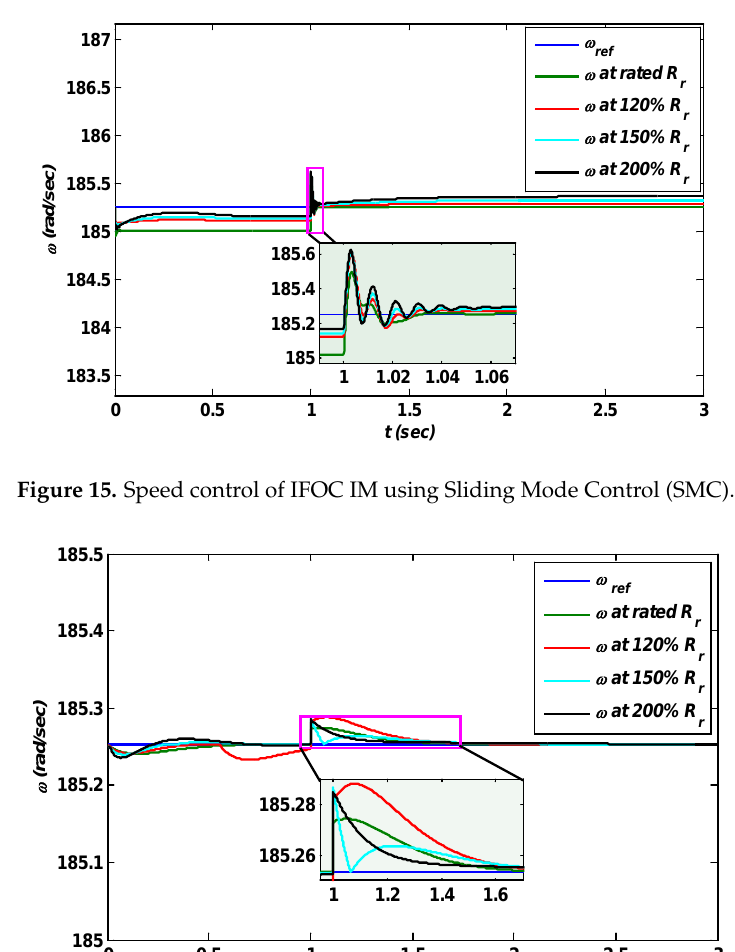
Figure 14. Speed control of IFOC IM using SD.